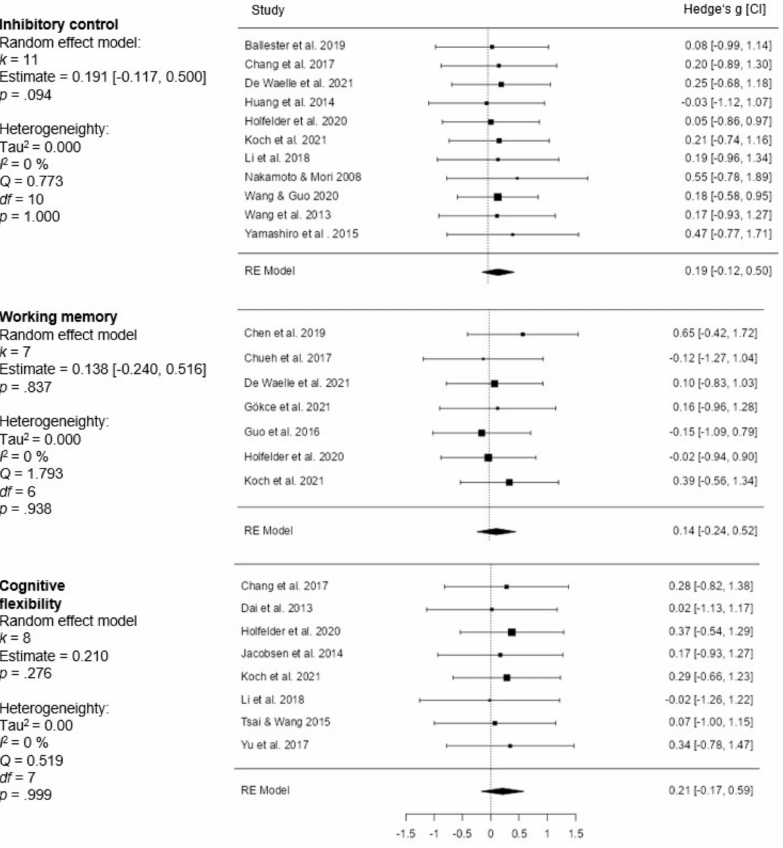
Figure 3. Forest plots of subgroup analysis (OSE vs. CSE); RE = random effect model [8,25–27,30,37–